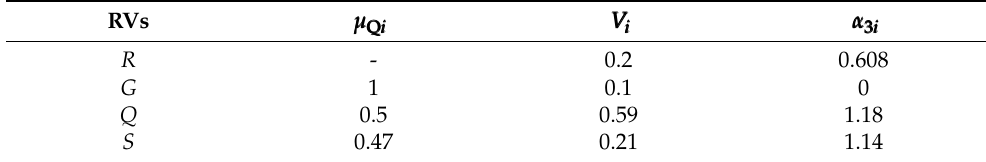
Table 1. Basic random variables for Equation